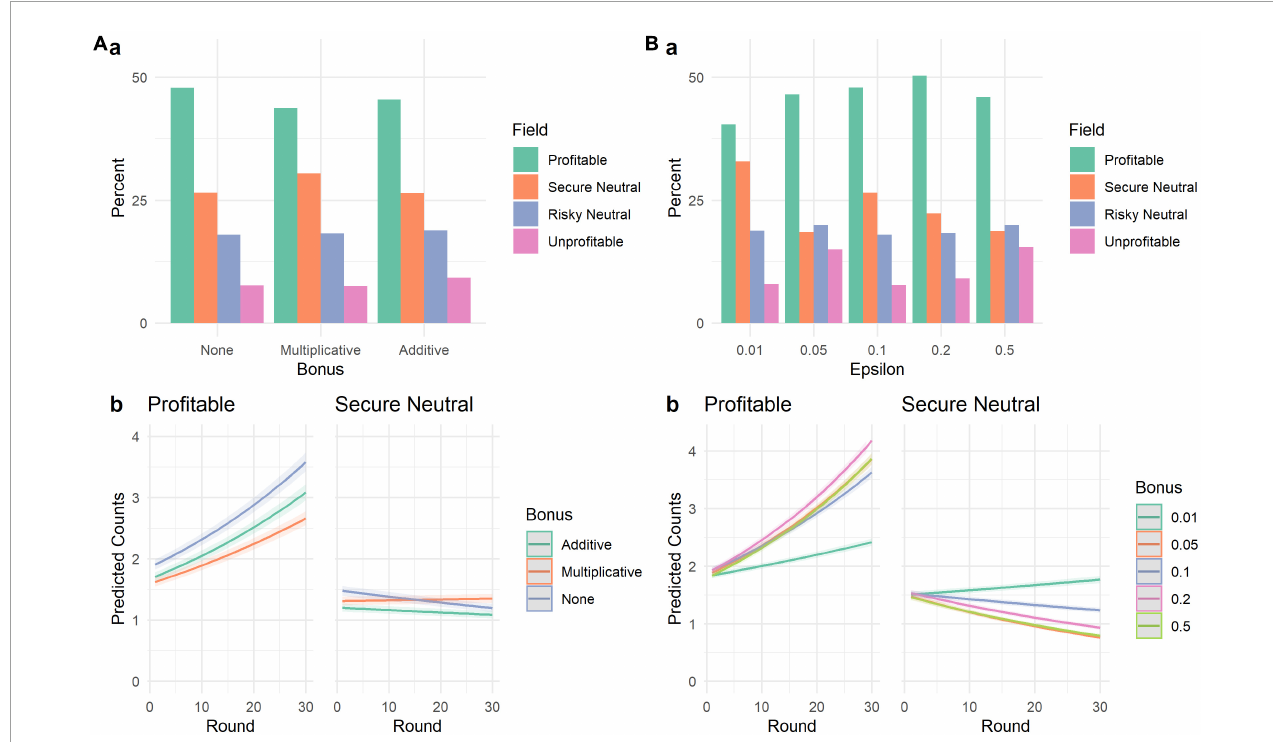
FIGURE1 Results of Study 1. ( A –upper panel) shows how often each field was chosen (in percent) by 6 simulated agents (30 rounds, 1,000 runs) with no group bonus (“None”), an additive bonus, and a multiplicative bonus. The lower panel (A–b) shows the predicted number of agents choosing the profitable or secure neutral field, depending on round and group bonus. ( B –upper panel) shows how often each field was chosen (in percent) by 6 simulated agents (30 rounds, 1,000 runs) with different exploration parameters (Epsilon). The lower panel (B–b) shows the predicted number of agents choosing the profitable or secure neutral field, depending on round and exploration